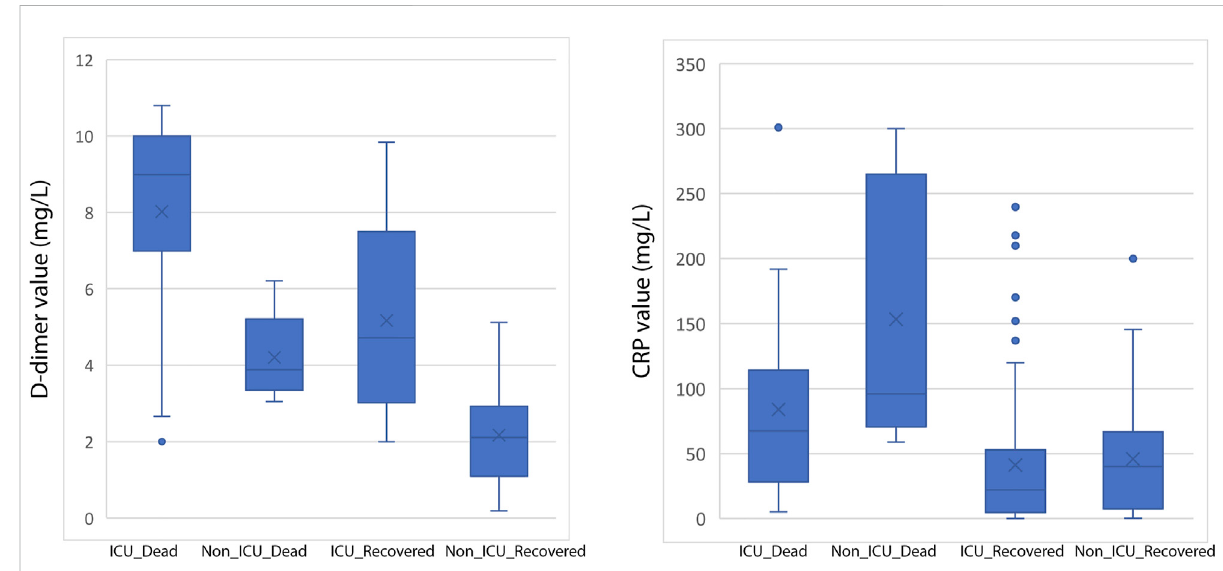
FIGURE 1 Box-and-whisker plot showing distribution of D-dimer (left) and CRP (right) values among various categories of COVID-19